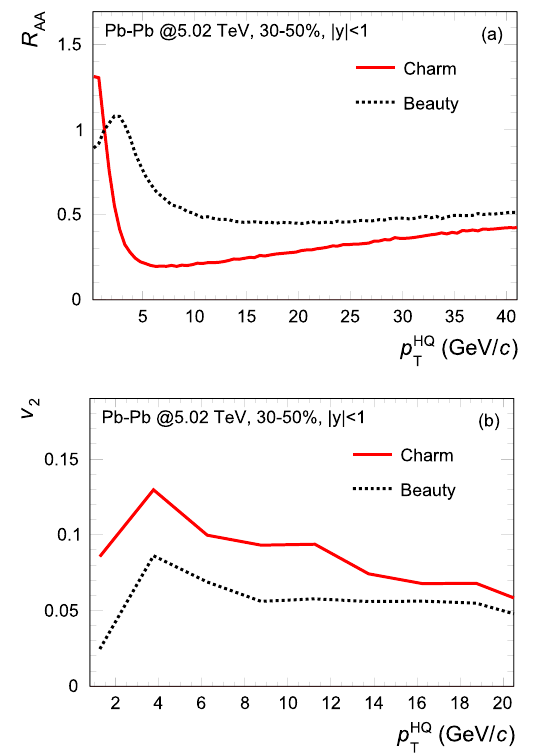
Fig. 3 Upper: nuclear modification factor R AA for charm (solid red curve)andbeautyquark(dashedblackcurve)insemi-central(30 − 50%) √ s NN = 5 . 02 TeV; Bottom: in analogy with the Pb–Pb collisions at upper panel but for the azimuthal anisotropy coefficient v 2 resulting in R AA ( beauty ) > R AA ( charm ) in this region.